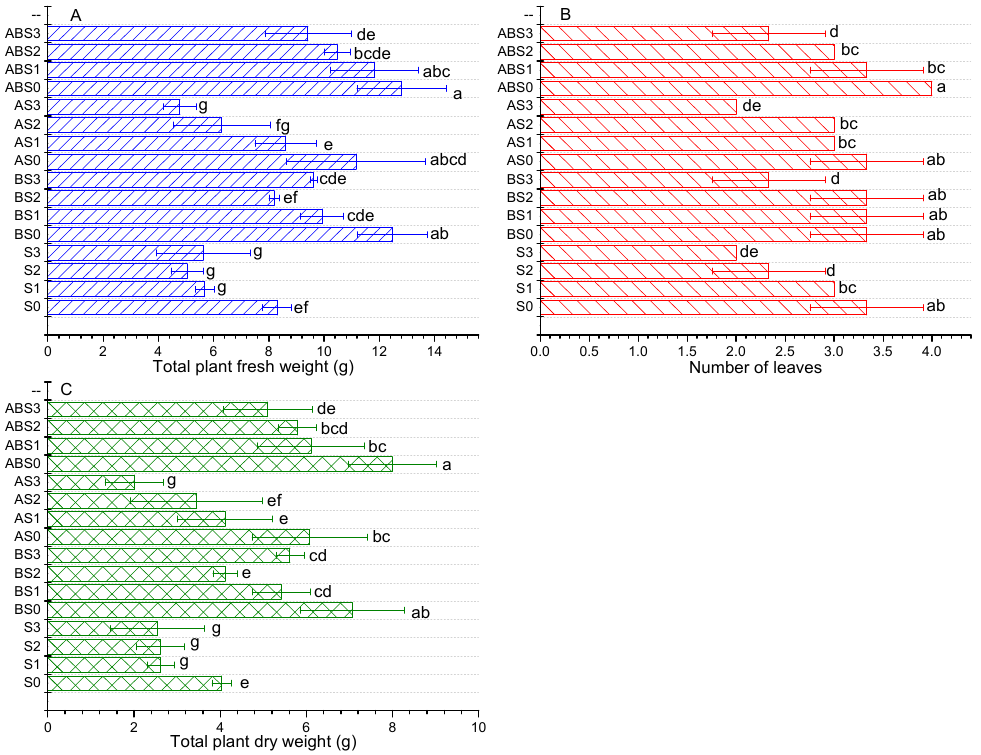
Figure 3. Impact of AMF and biochar on plant fresh weight ( A ), number of healthy leaves ( B ), and dry weight ( C ) under different concentrations of salinity. Data present the mean ± standard deviation of three replicates and mean values followed by different letters are significantly different at p < 0.05 according to Duncan multiple range test. The significance of acronyms is the same as in Figure 1.